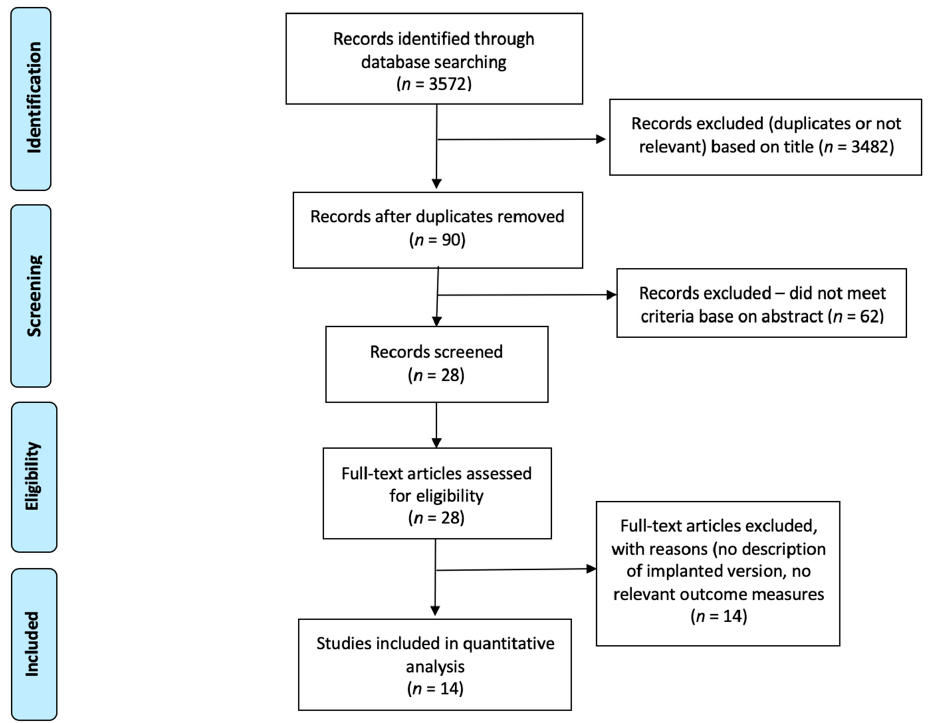
Figure 1. PRISMA flow diagram outlining study selection. Table 1. Summary of all included studies.